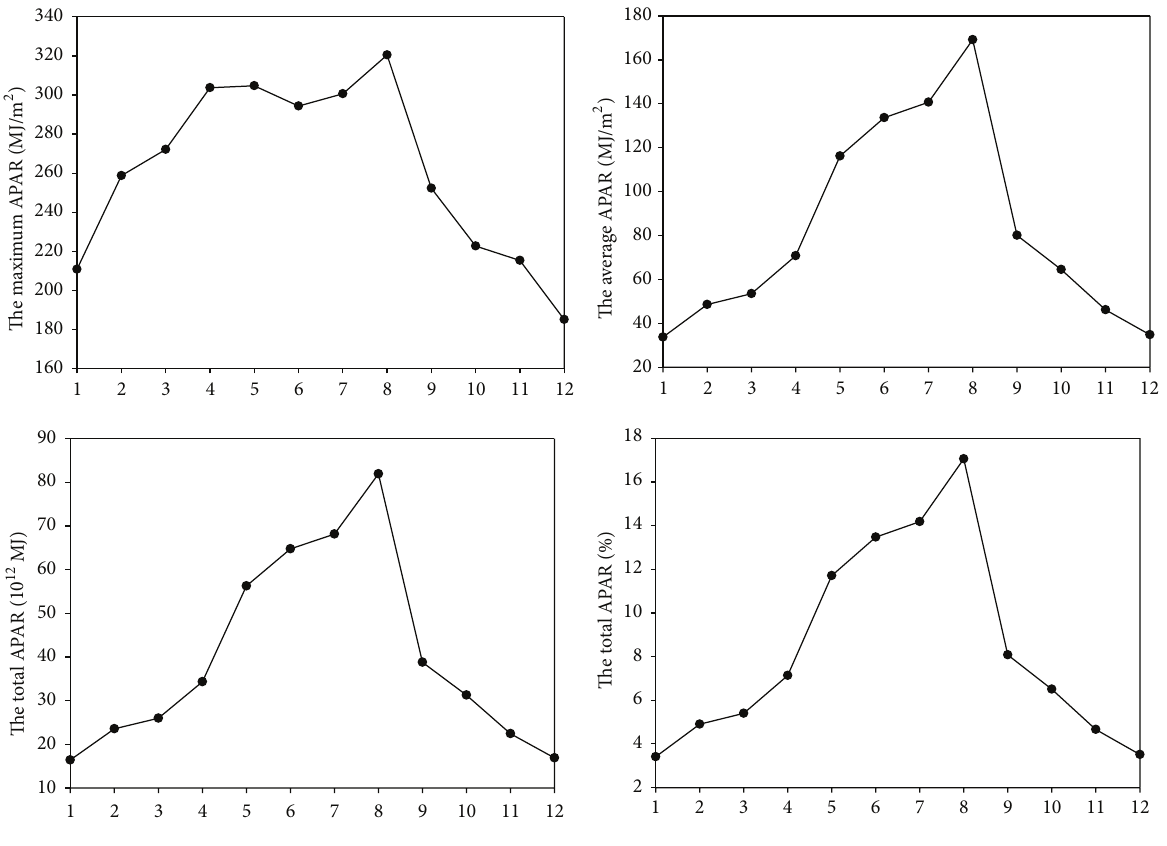
Figure 4: Monthly variation of APAR in 2011. Table 6: NPP for different ranges of